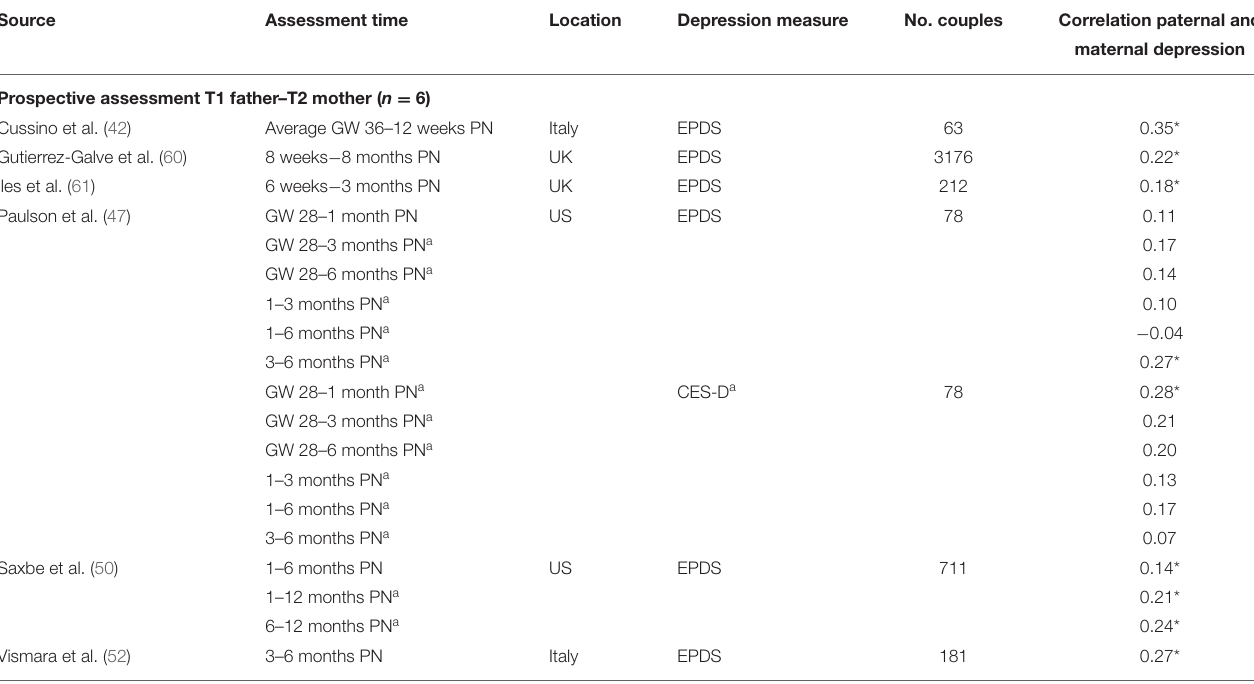
TABLE 1D | Characteristics of studies included in meta-analysis for the prospective association between maternal depression at one timepoint and paternal depression at a later